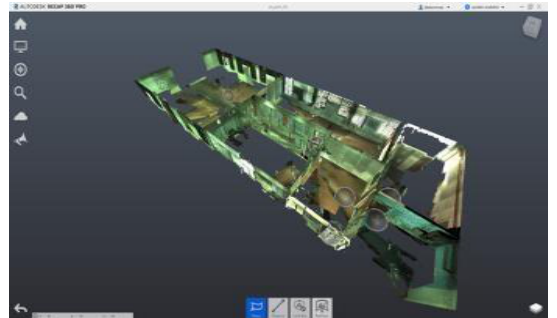
Figure 7: The parcel acquired from TLS viewed in Autodesk Recap.